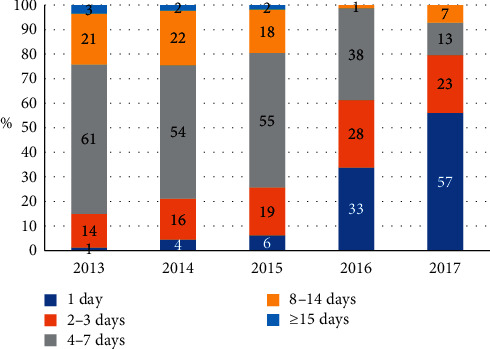
Hospitalization days in firework-related eye injury. In 2013 and 2014, few patients were hospitalized for only 1 day, and more than 50% of the patients stayed for 4–7 days. From 2015 to 2017, the proportion of patients who stayed for 1 day increased from 6% to 57%, while the proportion of patients who stayed for 4–7 days decreased from 55% to 13%.